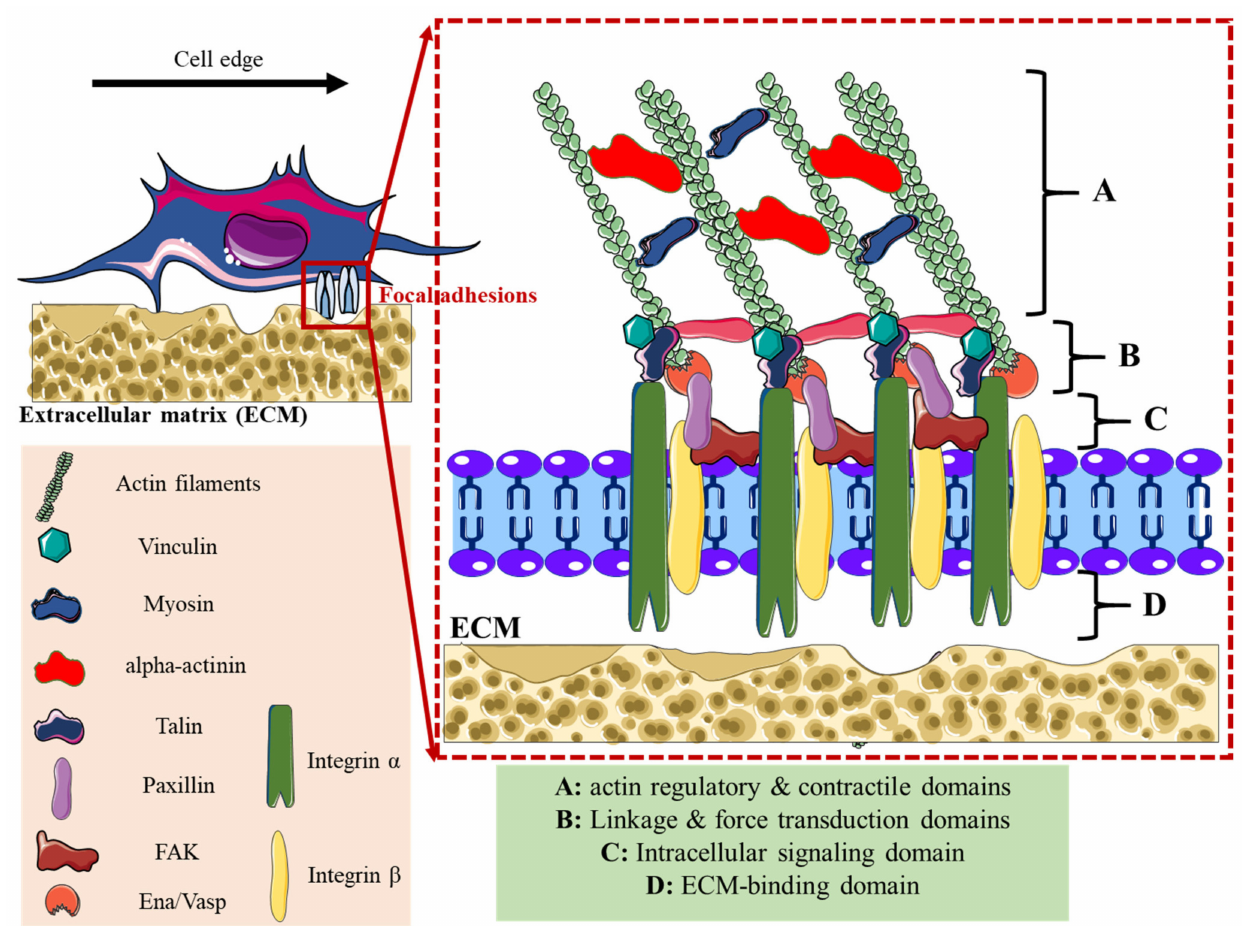
Figure 2. Schematic representation of focal adhesion structure and the different molecular domains. FA mediates the ECM-cell contact through integrin receptors (domain D). The integrin–integrin receptor engagement triggers the recruitment of critical kinases, such as FAK (domain C), to transduce the signal into structural changes in actin-linking proteins (domain B). As a result, the extracellular signal promotes actin filament mechanical force (domain A). The schematic simplifies the complex FA machinery to include those proteins that are most likely to be involved in the formation and structural integrity of